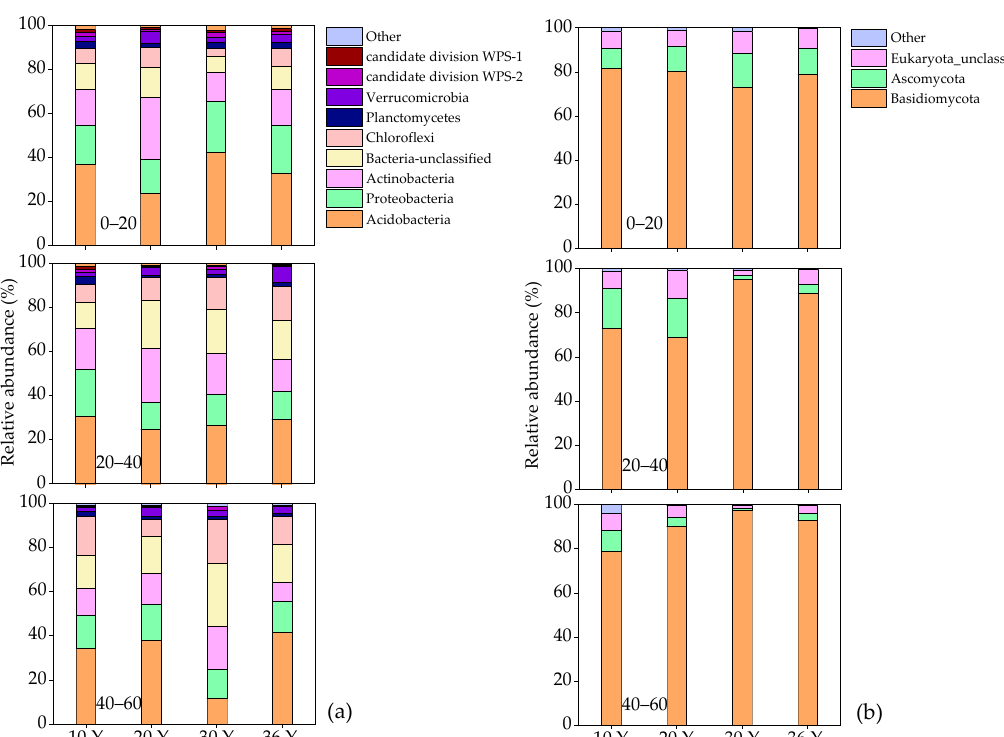
Figure 6. Relative abundance distribution of bacterial and fungal communities at the phylum level at different soil depths and stand ages. Phyla with more than 1% average abundance in at least one sample were considered as predominant. Figure ( a , b ) show the variation of relative abundance of bacteria and fungi, respectively. Other: the taxa of bacteria or fungi with relative abundance less than 1%; 10 Y: 10-year stand; 20 Y: 20-year stand; 30 Y: 30-year stand; 36 Y: 36-year stand; 0–20 cm: 0–20 cm soil depth; 20–40 cm: 20–40 cm soil depth; 40–60 cm: 40–60 cm soil depth.